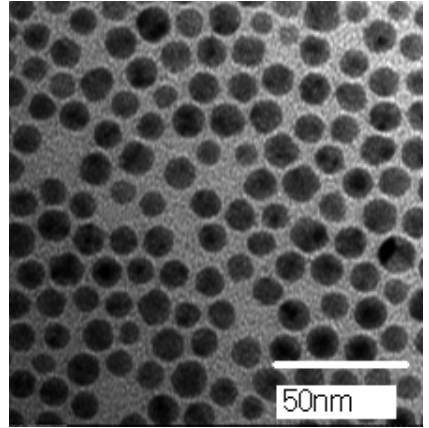
Figure 3. The TEM image of AgNPs.